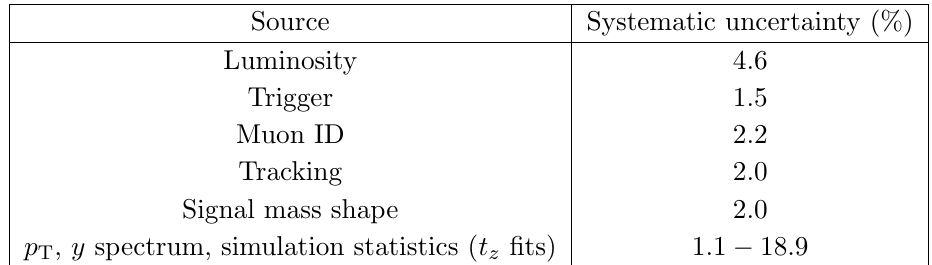
Table 4 . Relative systematic uncertainty (in %) on the ratio of the cross-section in pp collisions at p p s = 13 TeV relative to that at s = 8 TeV. The systematic uncertainty from t z (cid:12)ts only a(cid:11)ects J= -from- b .